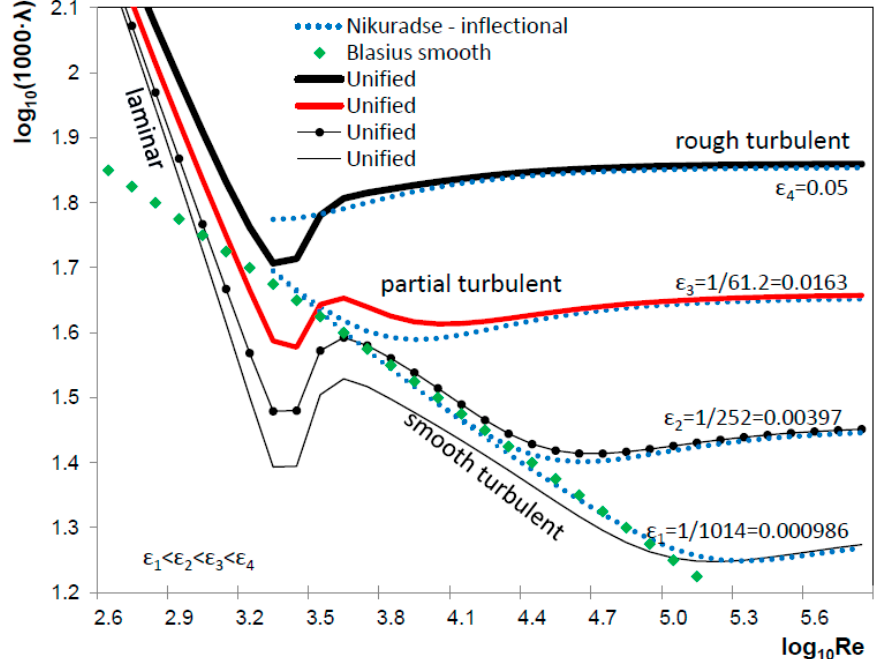
Figure 9. The unified hydraulic model I; Equation (15).